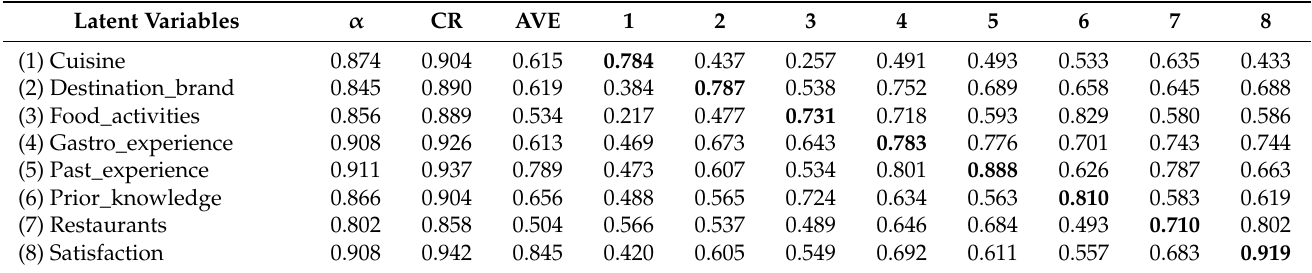
Table 3. Composite reliability, average variance extracted, correlations, and discriminant validity